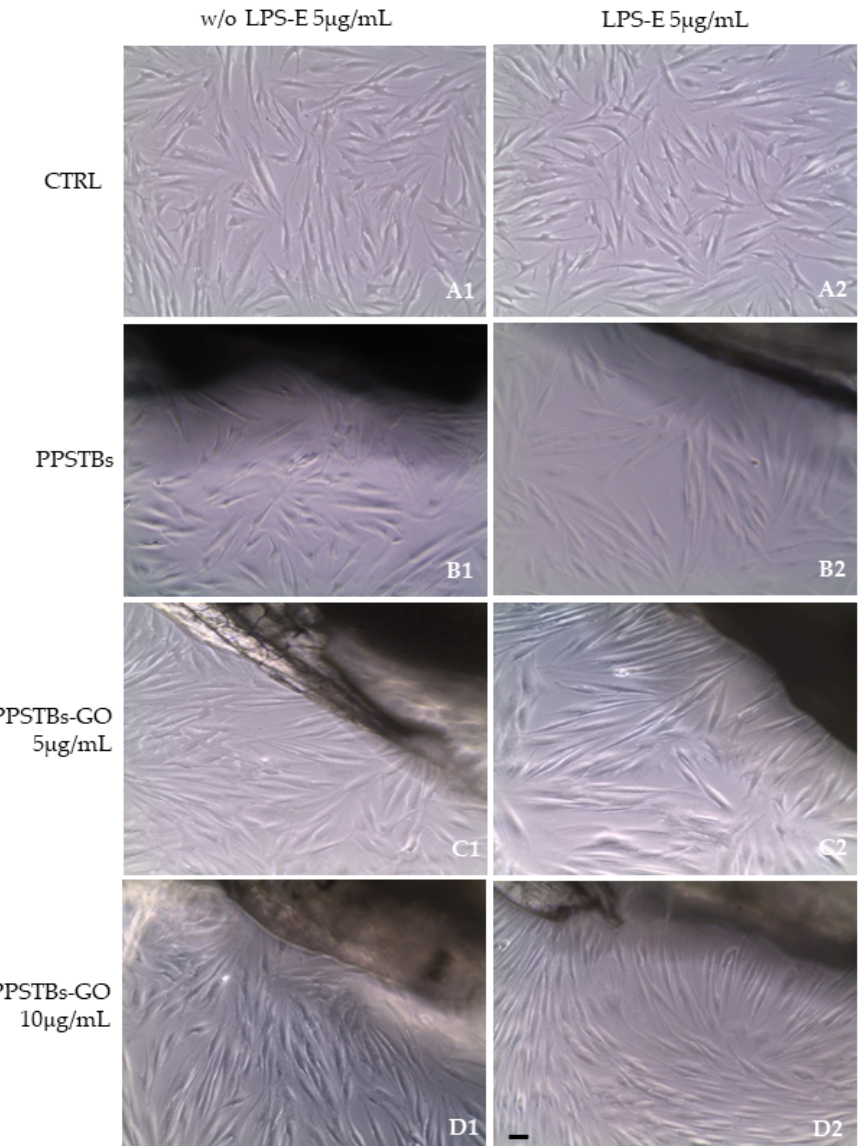
Figure 3. ( A1 – D1 ) The morphology of hGFs alone or cultured with PPSTBs, PPSTBs-GO 5 µ g/mL, and PPSTBs-GO 10 µ g/mL were observed at the inverted light microscope. ( A2 – D2 ) The morphology of hGFs alone or cultured with PPSTBs, PPSTBs-GO 5 µ g/mL, and PPSTBs-GO 10 µ g/mL and induced with LPS-E were observed at the inverted light microscope. Scale bar: 20 µ m. The SEM images showed that hGFs adhere equally on PPSTBs, PPSTBs-GO 5 µ g/mL, and PPSTBs-GO 10 µ g/mL both in the presence or in the absence of LPS-E treatment (Figure 4).